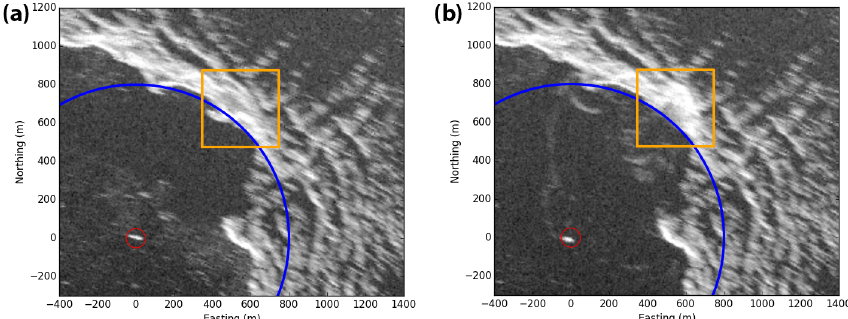
Figure 2. Radar signal intensity (MLI) plots of the glacier with the collapsed ice front (orange frame), the location of the tour boat (red circle), and a circle of 800m distance from the tour boat (blue). (a) Before the collapse (14:06UTC), (b) after the collapse (14:07UTC). Well visible in frame (b) is the crest of the tsunami wave that reaches the tour boat. The coordinate system is centered on the tour boat.